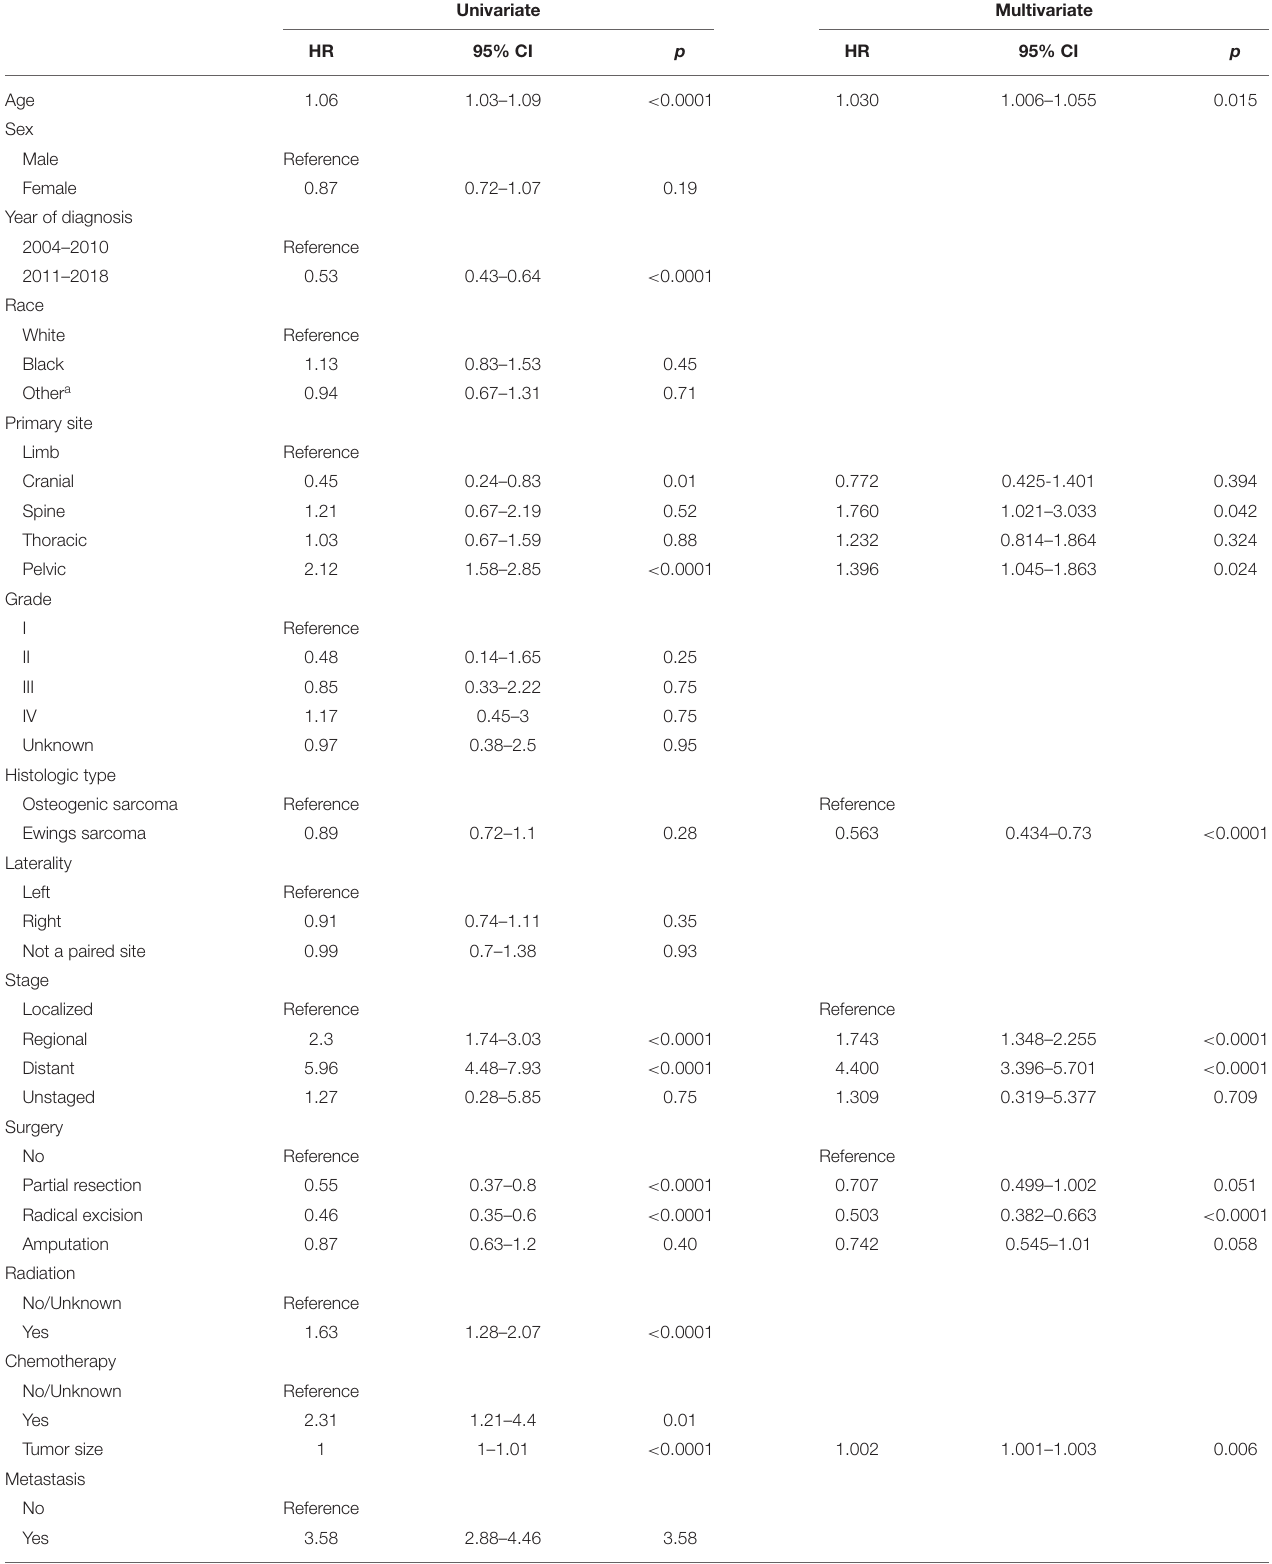
TABLE 2 | Univariate and multivariate analyses of CSS in bone tumor. Univariate